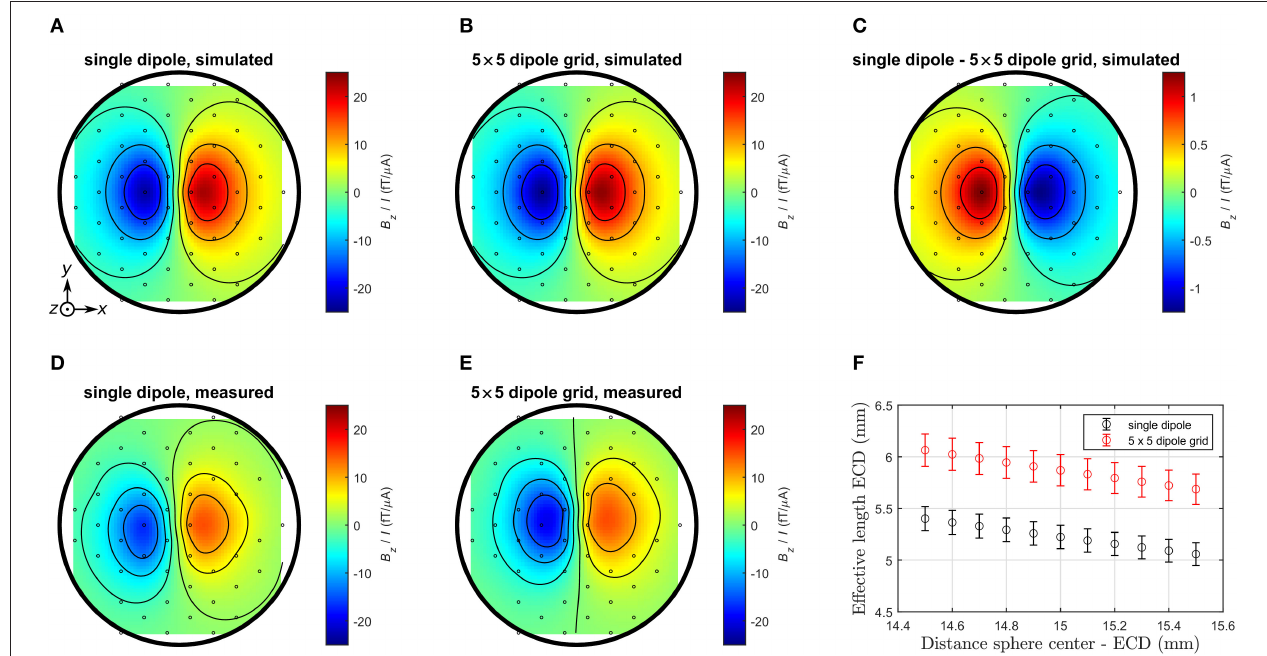
FIGURE 6 | Comparison of simulated and averaged measured field maps obtained for the bottom sensor array of the 304-channel system. (A) Simulation single dipole. (B) Simulation 5 × 5 dipole grid. (C) Simulation single dipole − 5 × 5 dipole grid. (D) Measurement single dipole. (E) Measurement 5 × 5 dipole grid. (F) Fitted effective length of each dipole source for different distances ECD—sphere center. Circles denote the coordinates of the z -sensors. For the simulated data, all 304 channels were used for the reconstruction. For the measured data, 97 channels were deployed and complete coverage of the bottom z -plane was not possible, as some were malfunctioning.